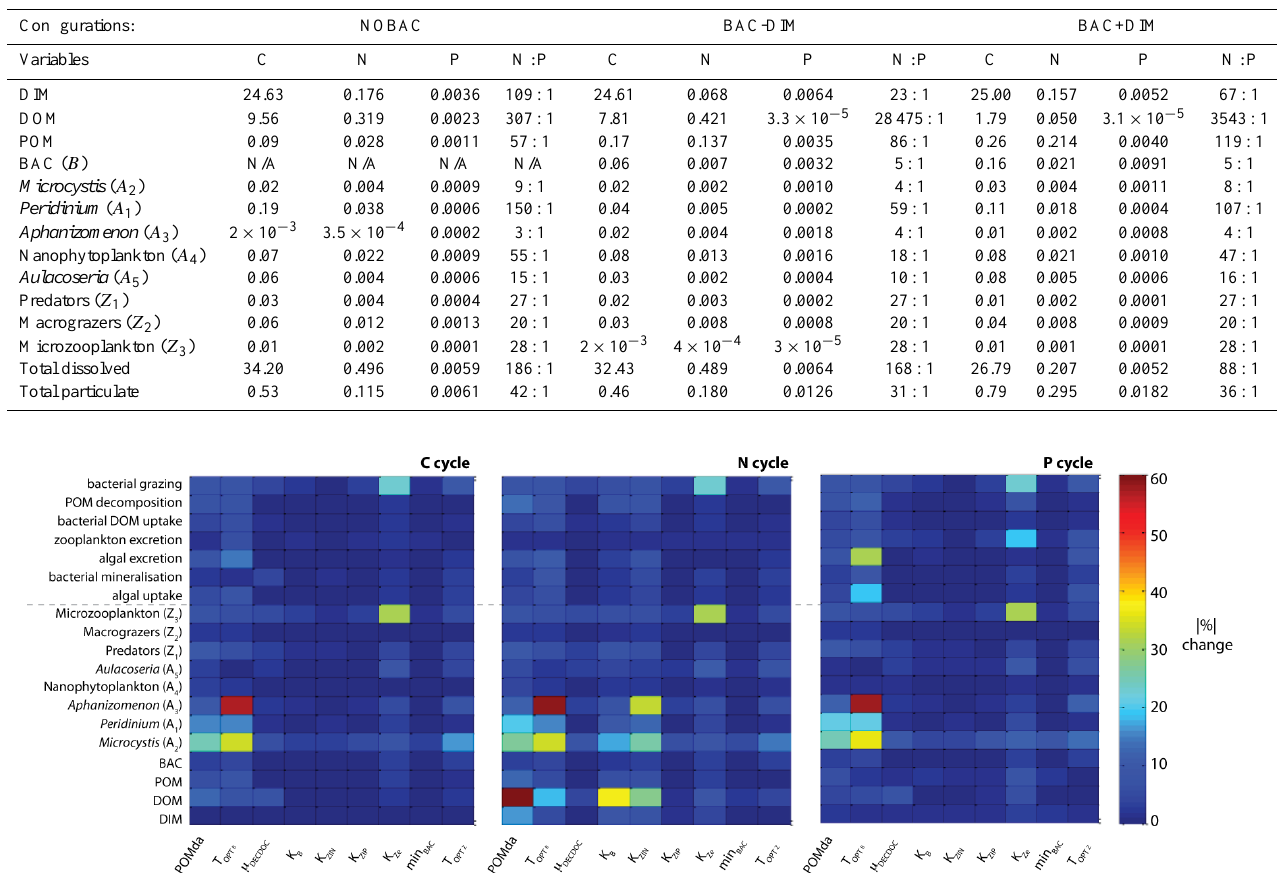
Table 6. Summary of average values (1997–2001) for C, N and P contents (mgL − 1 ) and N:P molar ratios of the various food web compo- nents in different microbial loop configurations.